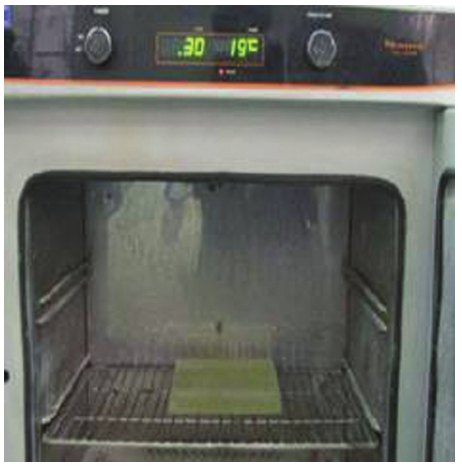
Figure 4 Evaporation of ethanol from impregnated fibers.